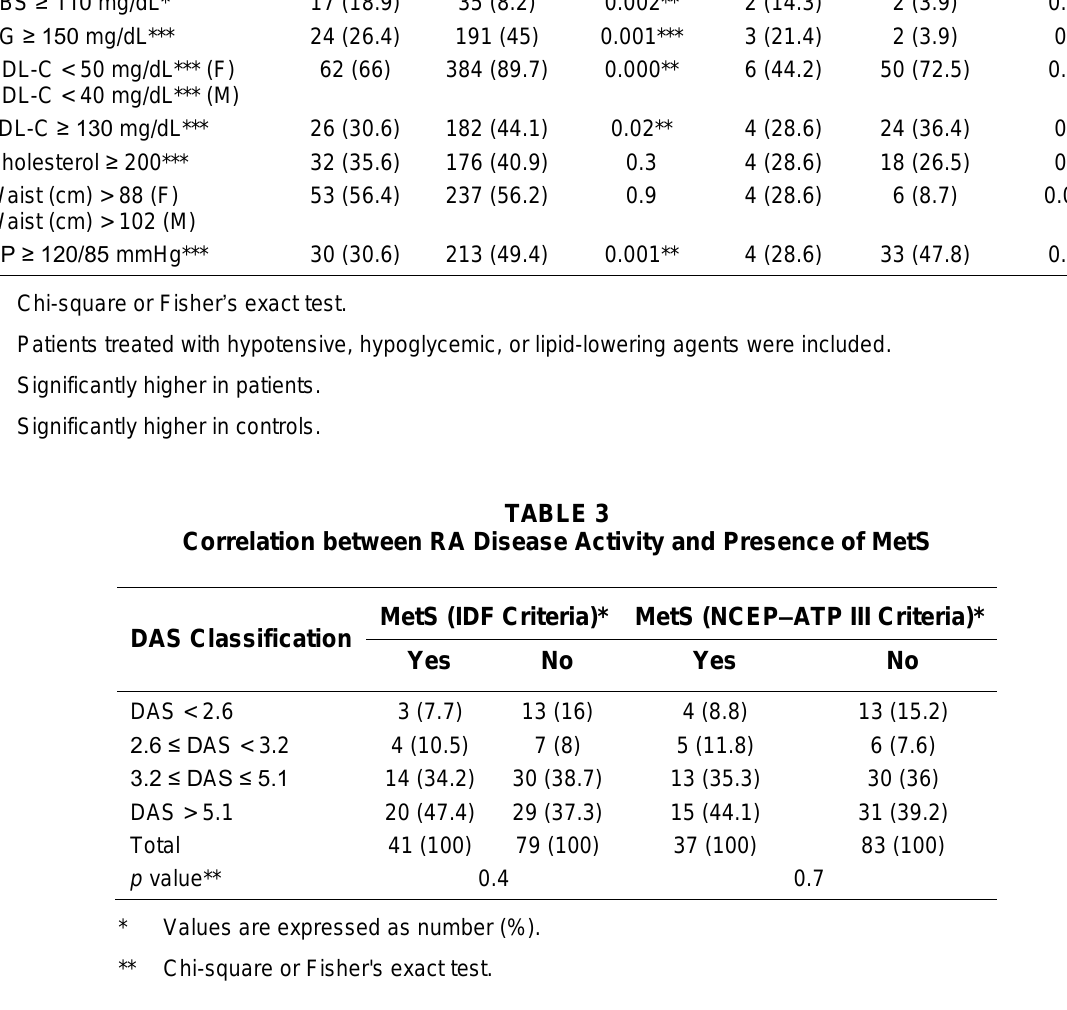
Frequency and Statistical Differences of Metabolic Components in Men and Women of Patient and Control Groups